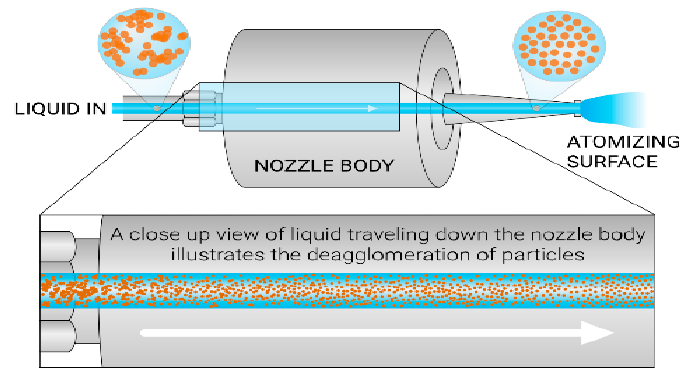
Figure 1. An illustration of an atomization process in the ultrasonic spray nozzle [43].